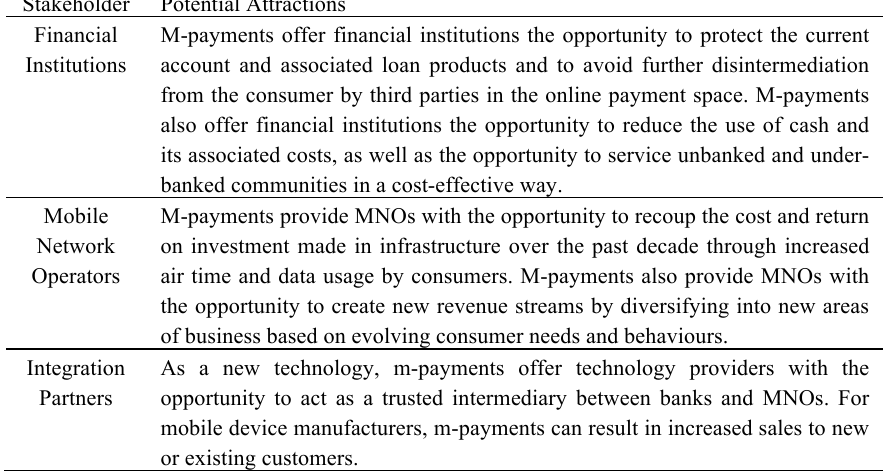
Table 2. Attractiveness of m-payments to the various